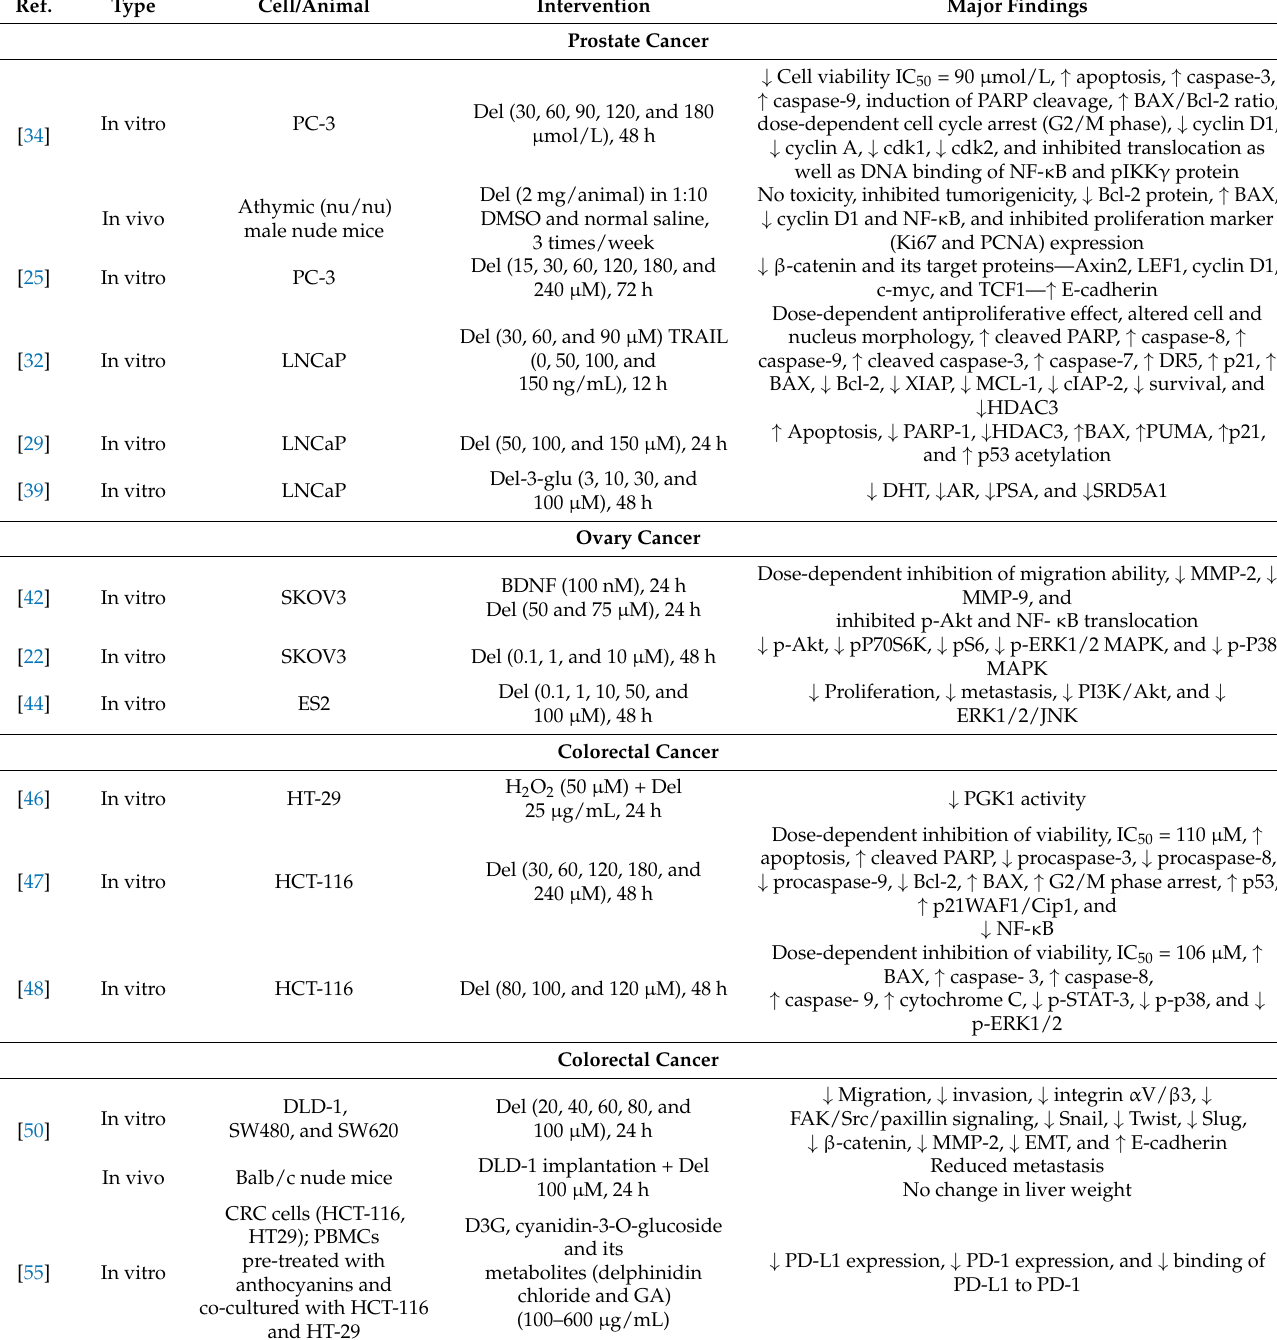
Table 1. Preventive and anticancer effects of delphinidin and its glycosides on models of prostate, ovary, colorectal, and lung cancer.